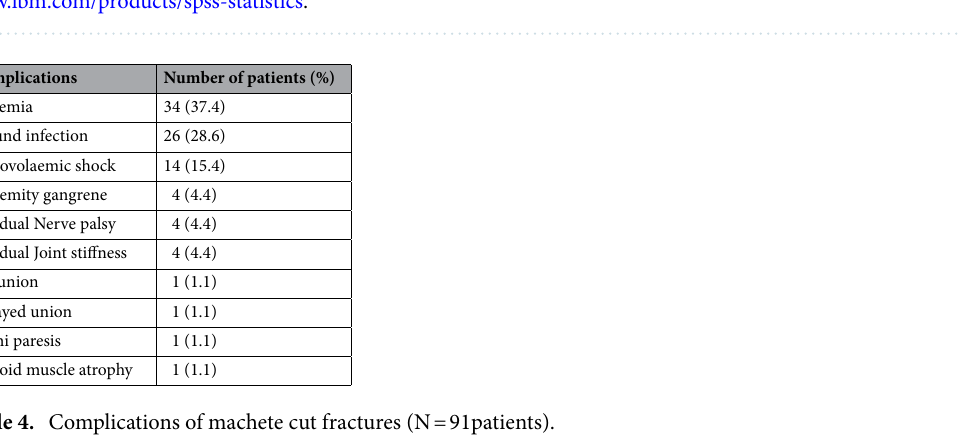
Figure 2. Distribution of fracture treatment by bone involved. Figure designed using IBM Statistical package for Social Sciences, IBM SPSS Statistics version 20 (IBM Corp. Armonk, N.Y. USA) statistical soft ware https :// www.ibm.com/produ cts/spss-stati stics .